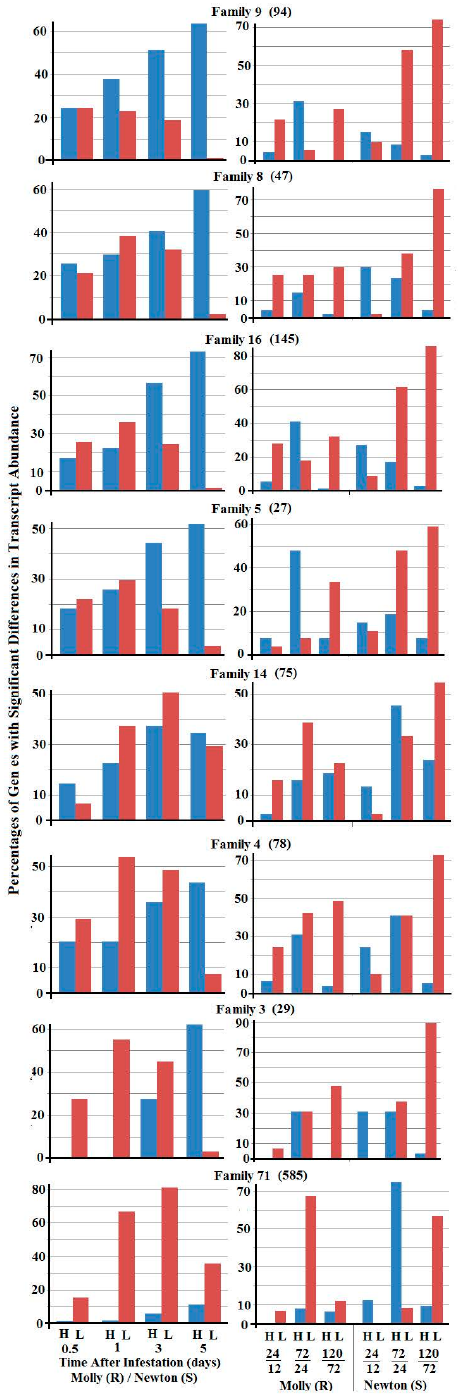
Figure 5. Percentages of secreted salivary gland protein (SSGP) genes in selected families with higher (blue bars, H) and lower (red bars, L) transcript abundance between larvae feeding on resistant (Molly) and two susceptible (Newton) plants at 0.5, 1, 3, and 5 days ( left panels), and between two successive stages (1 versus 0.5 day, 3 versus 1 day, and 5 versus 3 days) of Hessian fly larvae feeding in either resistant (Molly) or susceptible (Newton) plants ( right panels). Gene families are marked on each pair of graphs. The numbers of genes in each gene family were given in parenthesis.